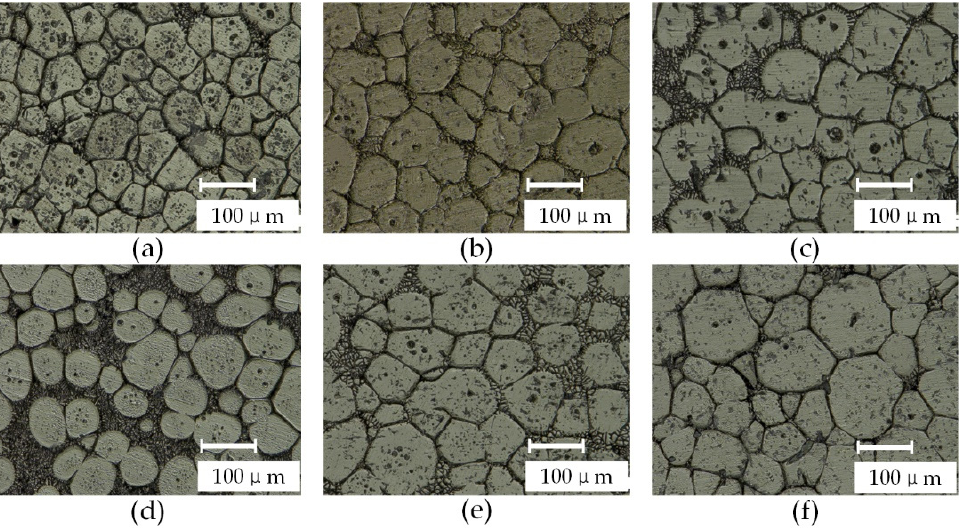
Figure 5. Microstructure of isothermal heat treatment at a different time when holding temperature is 650 °C, ( a ) 10 min, ( b ) 15 min, ( c ) 20 min, ( d ) 25 min, ( e ) 30 min, and ( f ) 35 min.